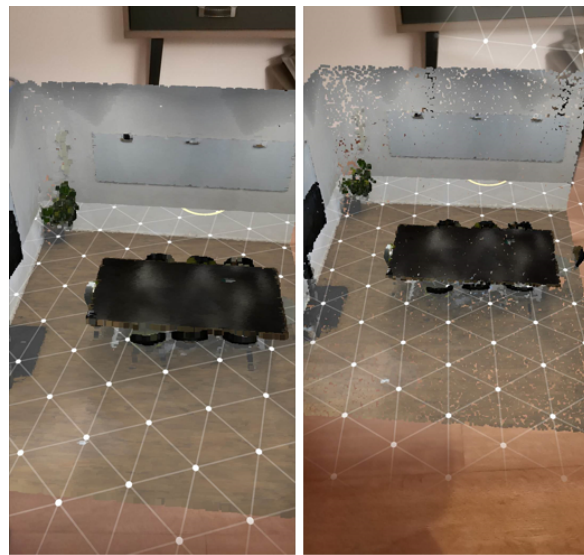
Figure 2. Points with adaptive size(left) and with same size(right)